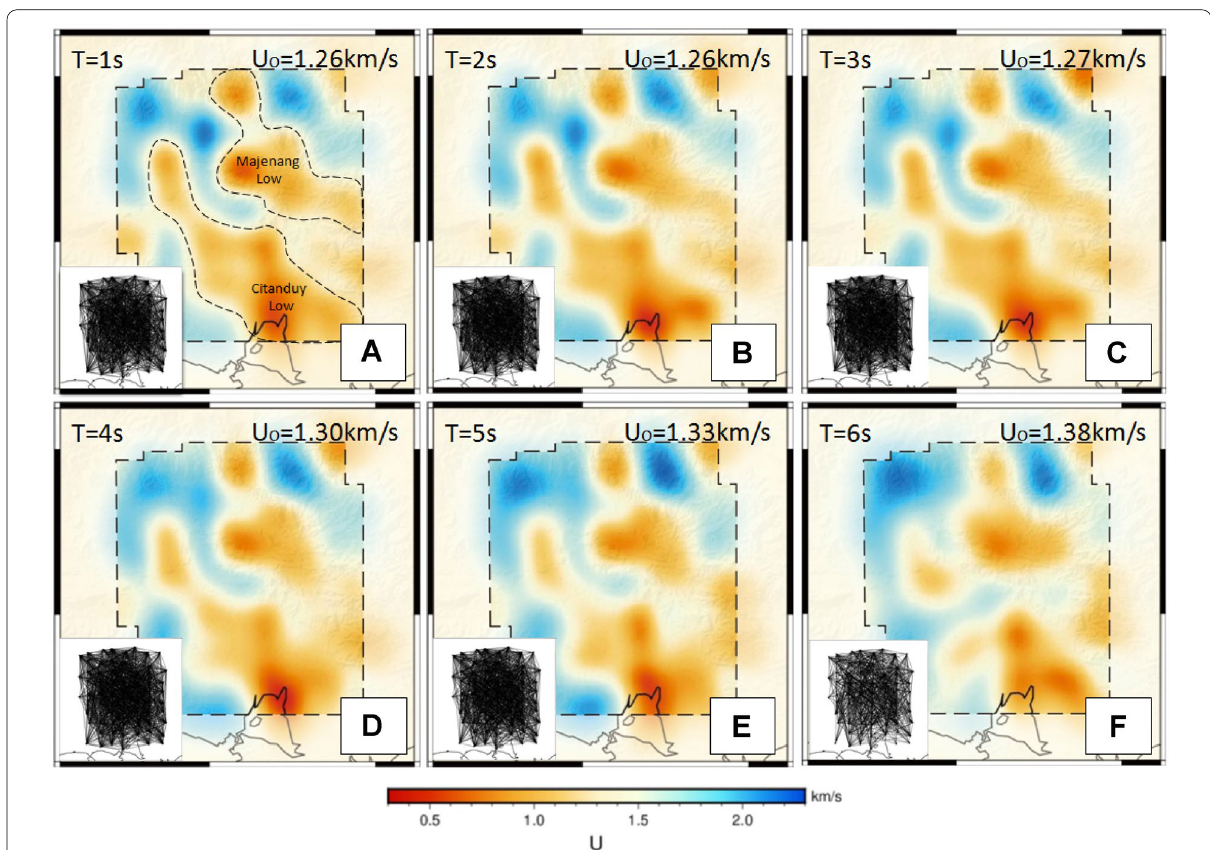
Fig. 4 A–F The Rayleigh wave group velocity map at periods 1 s to 6 s. The ray path was shown in the inset map. The low group velocity,